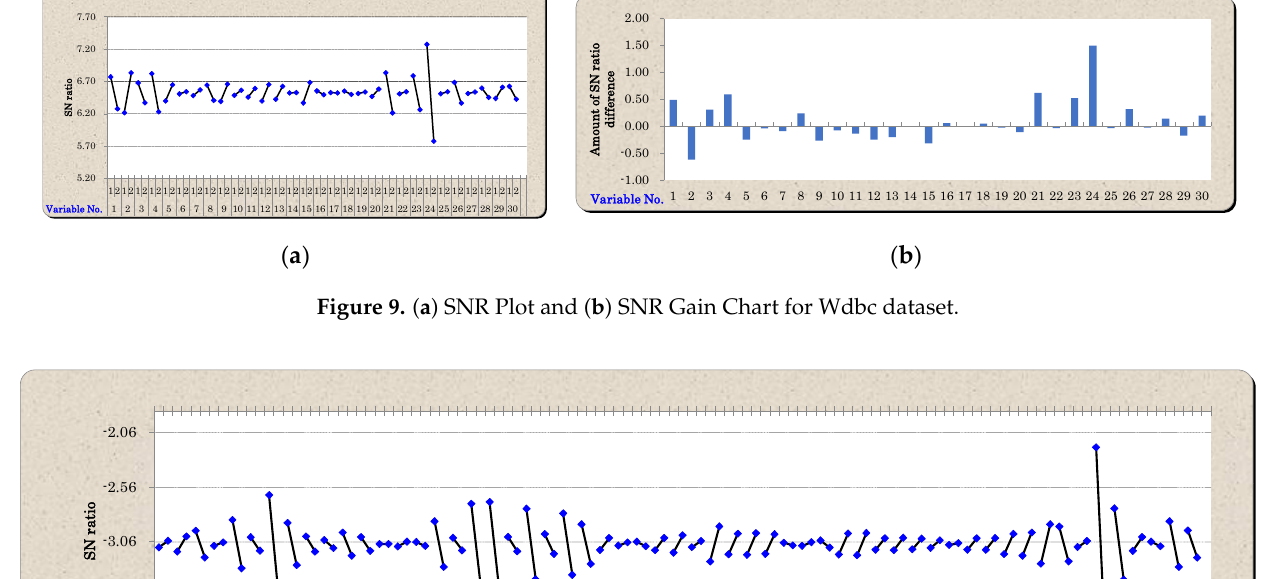
Figure 8. ( a ) SNR Plot and ( b ) SNR Gain Chart for Medical Diagnosis of Liver Disease dataset.